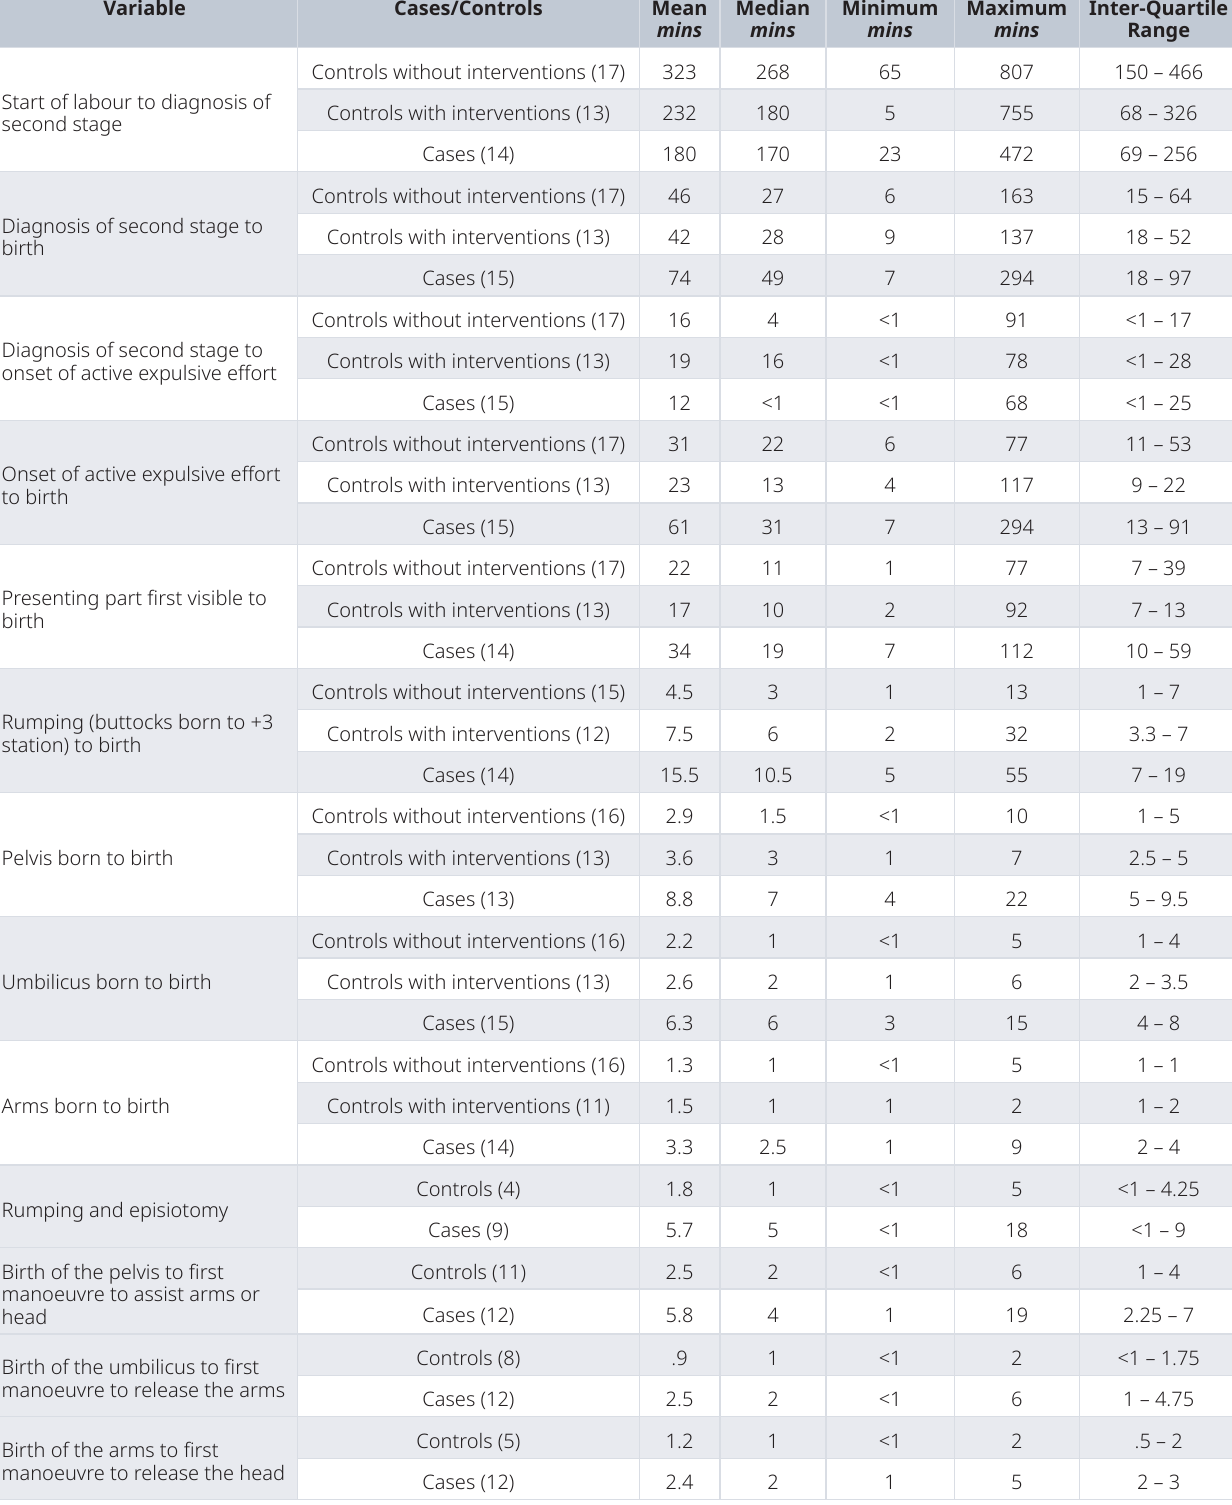
Table 2. Intervals of emergence and other